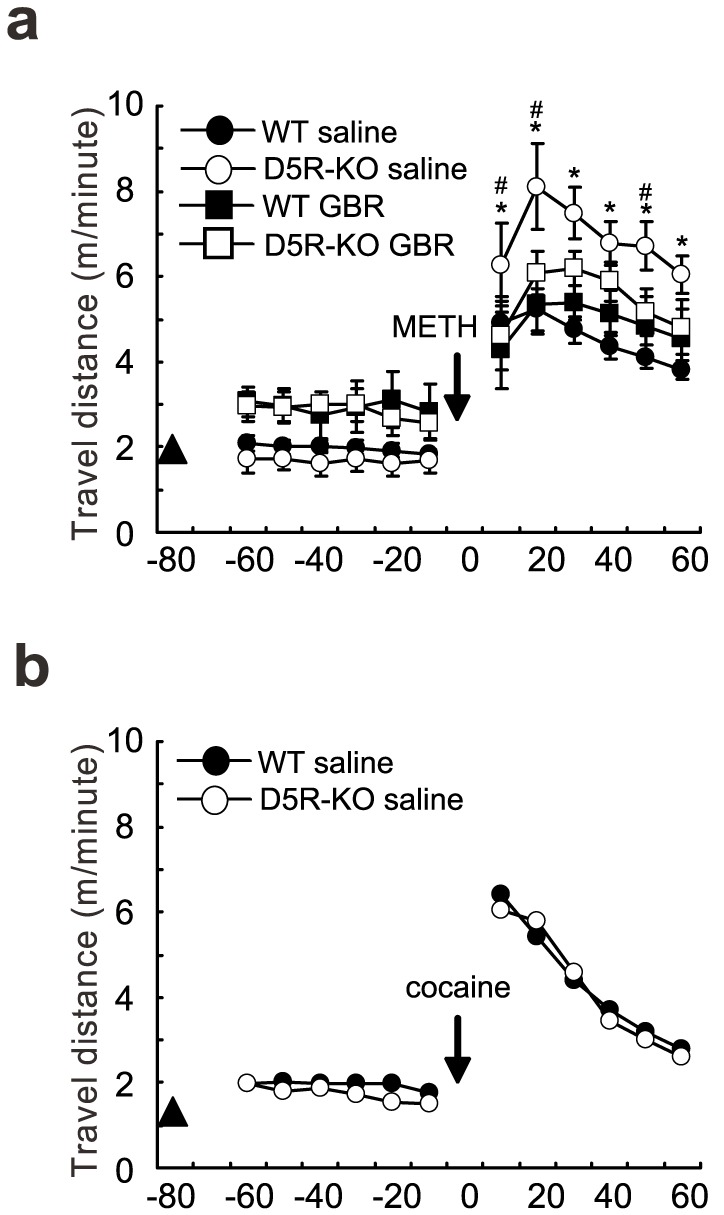
Increased METH-induced ambulatory activity in D5R-KO mice.(a) Open field locomotor activity after challenge with METH (2.5 mg/kg). Locomotion was measured for 60 min following each injection. The data were presented in 10 min time bins. The circles or squares represent the mean and the error bars represent the s.e.m. The pretreatments (arrowhead) were either saline (WT, filled circles, n = 6; and D5R-KO, open circles, n = 6) or GBR12909 (5 mg/kg) (WT, filled squares, n = 6; and D5R-KO, open squares, n = 6). The pretreatments were administered 80 minutes before the METH challenge (arrow). The secondary interaction between blocker pretreatment, genotype, and time course was: F(11,220) = 3.08; and p<0.001. The interactions between blocker and genotype at various time points (20, 30, 40, and 50 min after the METH challenge) were F(1,240) = 5.29, 5.63, 4.04, and 6.01; and p<0.05at all time points. The main effects of genotype (saline pretreatments) at various time points (10, 20, 30, 40, 50, and 60 min after the METH challenge) were F(1,240) = 4.08, 18.07, 20.08, 15.01, 15.58, and 7.56; and p = <0.05, p<0.0001, p<0.0001, p<0.001, p<0.001, and p<0.01, respectively. The main effects of GBR12909 on D5R-KO mice at various time points (10, 20, and 50 min after the METH challenge) were F(1,240) = 5.37, 7.99, and 4.68; and p<0.05×10−2, p<0.01, and p<0.05, respectively. * p<0.05 for main effect of genotype; and # p<0.05 for main effect of blocker. (b) Open field locomotor activity after challenge with cocaine (15 mg/kg). Ambulation of two experimental groups of mice (n = 8 each) after cocaine challenge. Saline injection (arrowhead) was performed 80 minutes before the cocaine challenge (arrow). WT, filled circles; D5R-KO, open circles. The interaction between genotype and challenge was F(1,154) = 1.00 and p = 4.49×10−1.